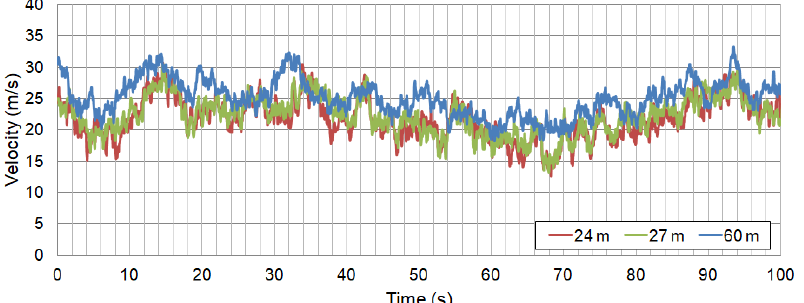
Figure 3. Typical wind speeds for heights of 24 m, 27 m and 60 m for the same horizontal alignment.